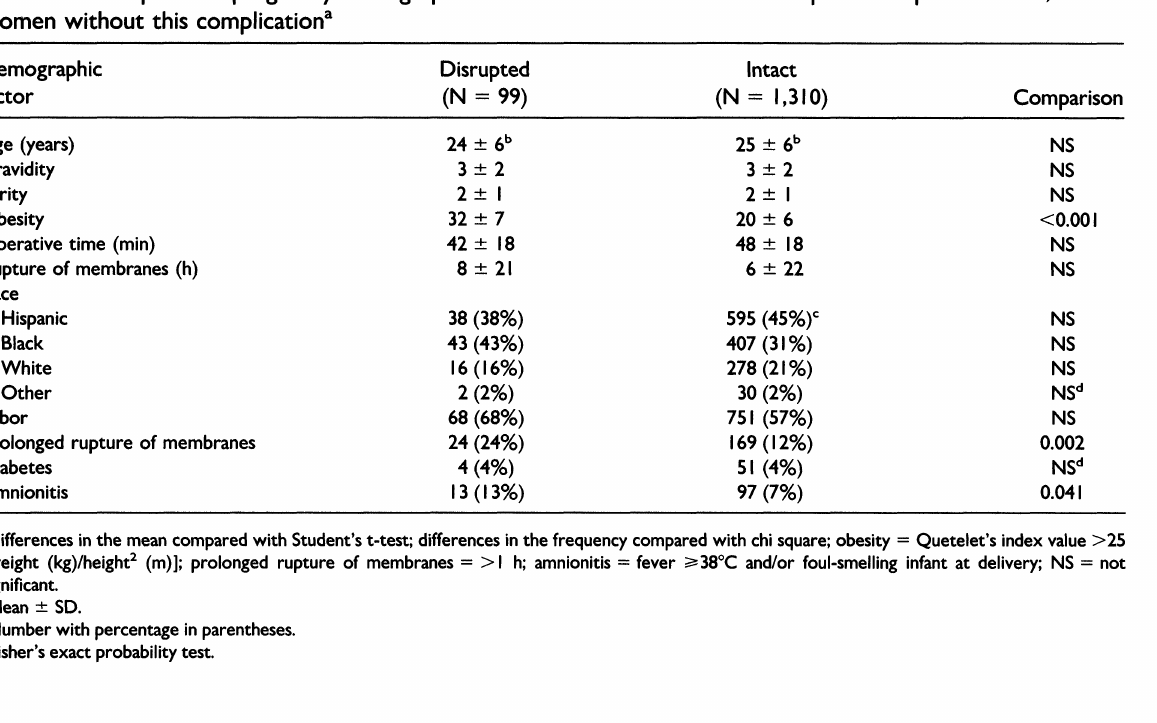
TABLE 3. Preoperative pregnancy demographics in 99 women with wound disruption compared with